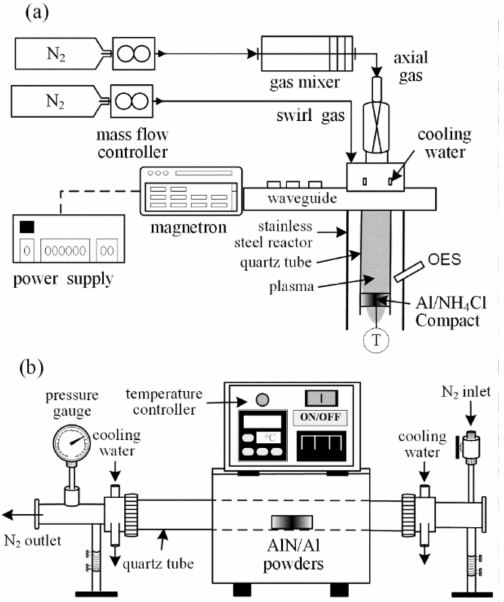
Figure 1. Schematic of synthesis apparatus ( a ) plasma-nitridation system, ( b ) thermal-nitridation